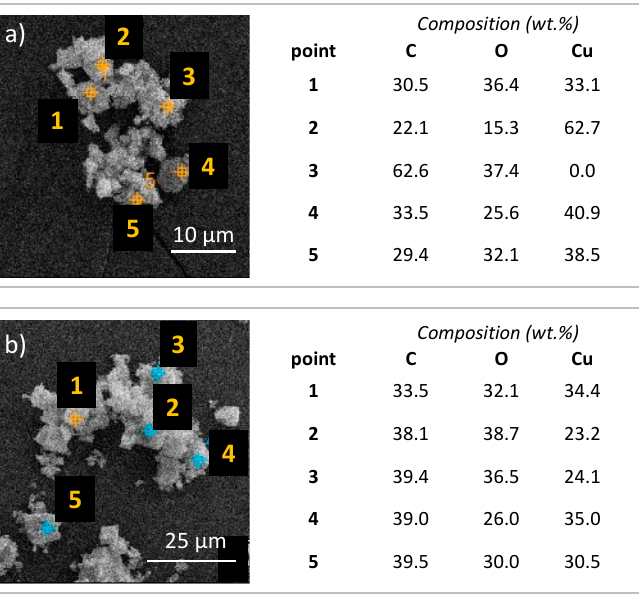
Figure 4. Composition of the H1/G_B ( a ) and H1/G(Cu)_B ( b ) composites determined by EDS in selected points of the samples.